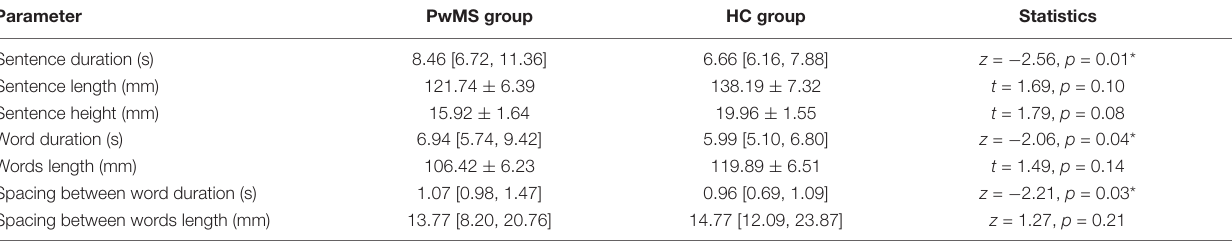
TABLE 1 | Kinematic parameters describing the handwriting task performed by PwMS and